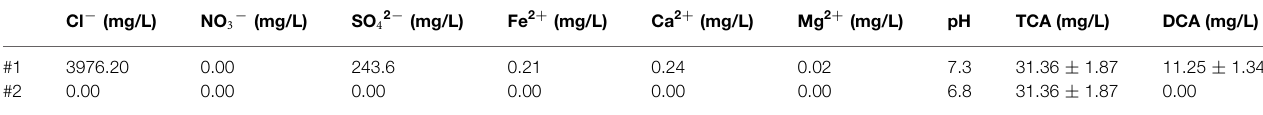
TABLE 1 | Chemical parameters of influent solution.